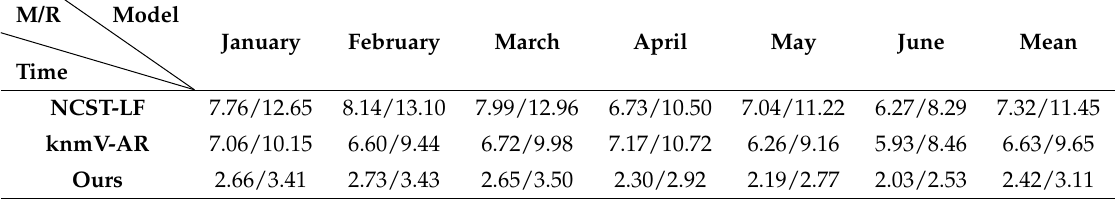
Table 5. Forecast errors of different spatiotemporal correlation based